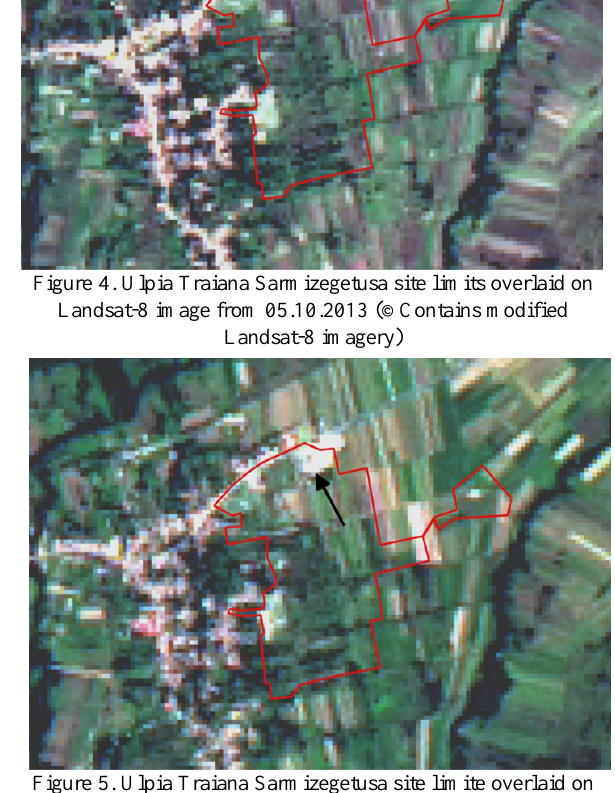
Figure 5. Ulpia Traiana Sarmizegetusa site limite overlaid on Landsat-8 image from 17.09.2018 (©Contains modified Landsat-8